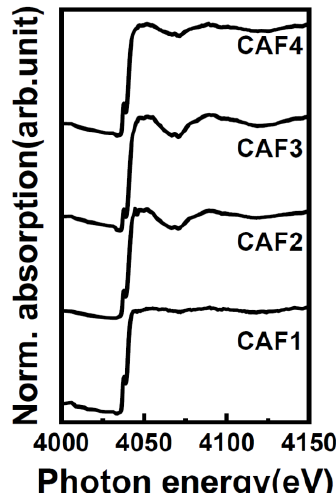
Figure 3. ( a ) Solid state UV-vis spectra and ( b ) Tauc plot of Ca – Al – Fe LDHs with various Ca/Al/Fe ratios.